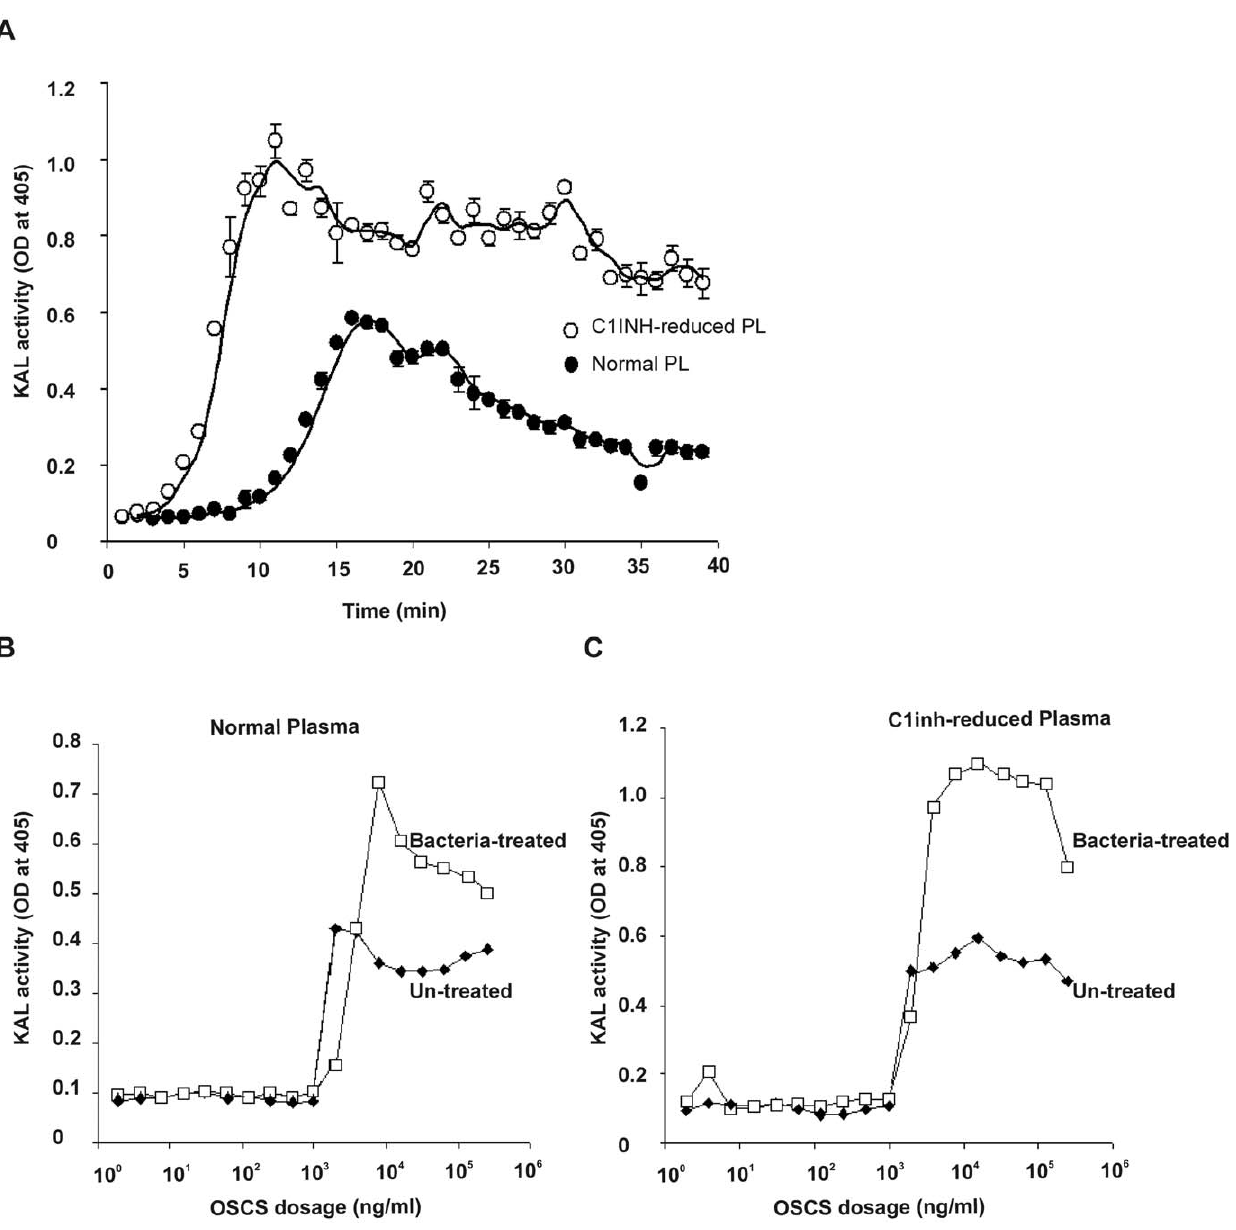
Figure 3. OSCS kallikrein activation kinetics and dose response. (A) Kinetics of kallikrein activation in normal plasma and C1inh-depleted plasma with the addition of 25 m g/ml of OSCS. Kallikrein activity was also determined in (B) normal human plasma and (C) C1inh-depleted plasma with different doses of OSCS. The OSCS dose response was also evaluated with plasma samples treated with antibody-coated bacteria. Experiments were repeated independently twice. Duplicate samples were used in panel